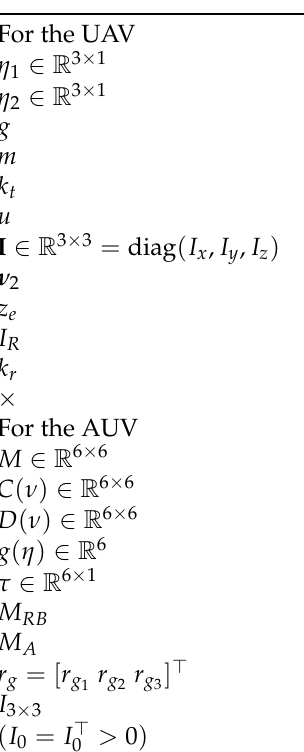
Table 1. List of the main